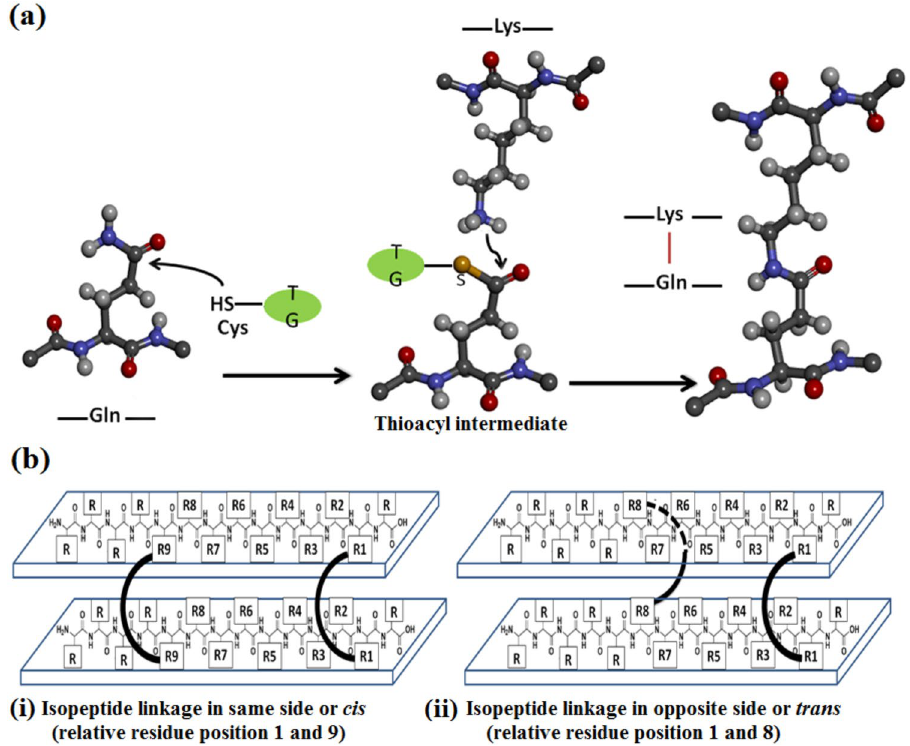
Figure 1. ( a ) Transglutaminase mediated formation of the intermolecular isopeptide bond. ( b ) Schematic representation of orientations of two possible isopeptide bond formation between two different peptide molecules having β -sheet conformations : (i) cis , where both the isopeptide bonds are formed in the same side of the two peptides and (ii) trans , where the isopeptide bonds are formed in the opposite side of the two